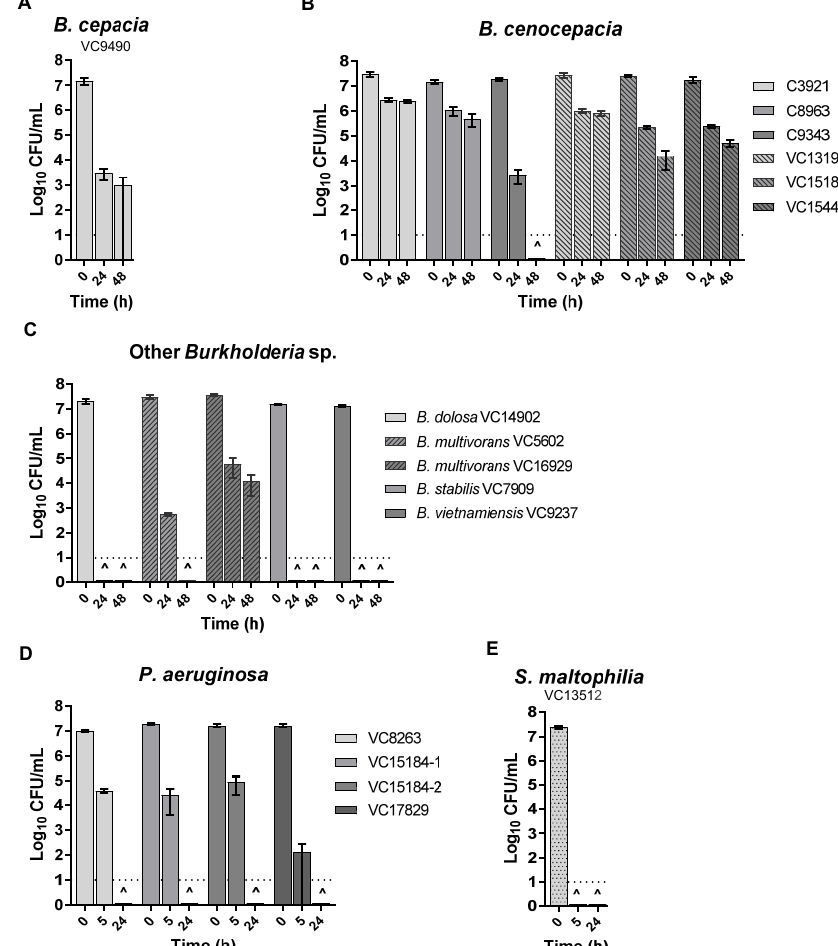
Figure 2. Effect of aqueous leachate of KC (L100) on the viability of B. cepacia complex isolates ( A – C ), P. aeruginosa isolates ( D ), and S. maltophilia isolate ( E ). CFUs have been determined at 0 h, 5 h, 24 h, and 48 h of incubation. ^ indicates that no viable cell could be recovered at that time point. Error bars represent the standard error (SE) of the mean of three independent replicates of each strain. The dotted line at log 10 = 1 of the Y axis represents the limit of detection for CFUs.